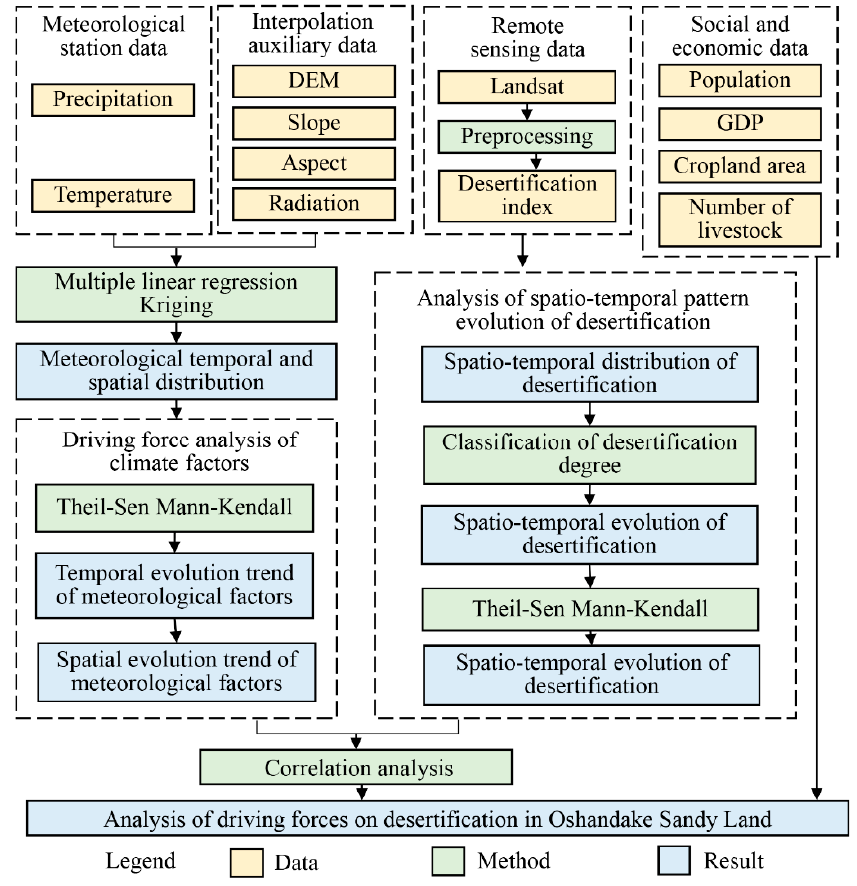
Figure 1. Spatio ‐ temporal patterns and driving forces of desertification in OSL. Figure 1. Spatio-temporal patterns and driving forces of desertification in